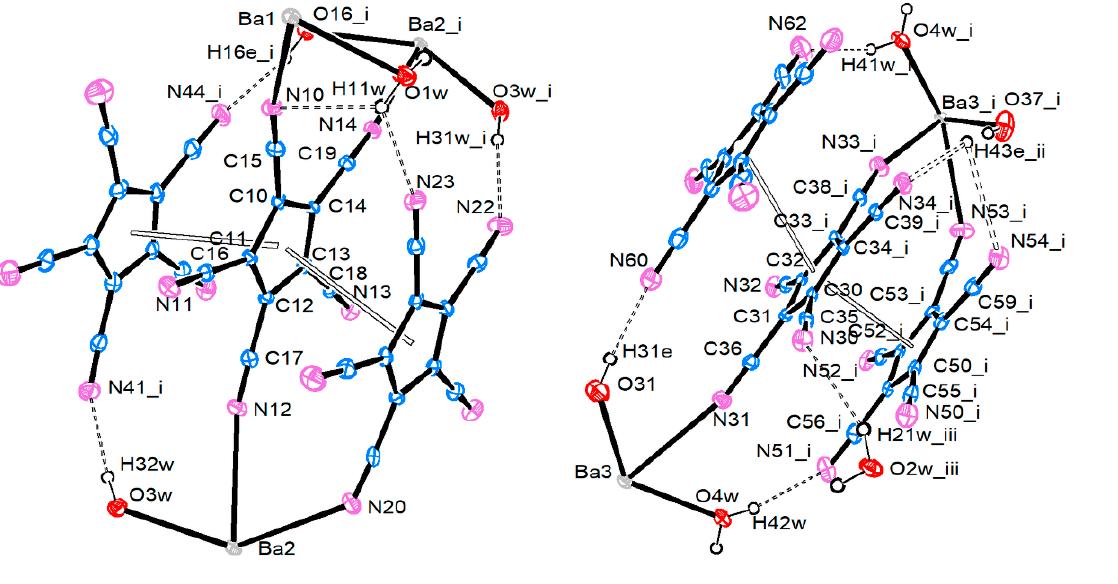
Figure 23 . ( left ) The three anions bridging Ba1, Ba2, and Ba2_i (symm. Code i: − x , 1 − y , z − ½ ). ( right ) The three anions bridging Ba3 and Ba3_i (symm. Code i: − x , 1 − y , z − ½ ).